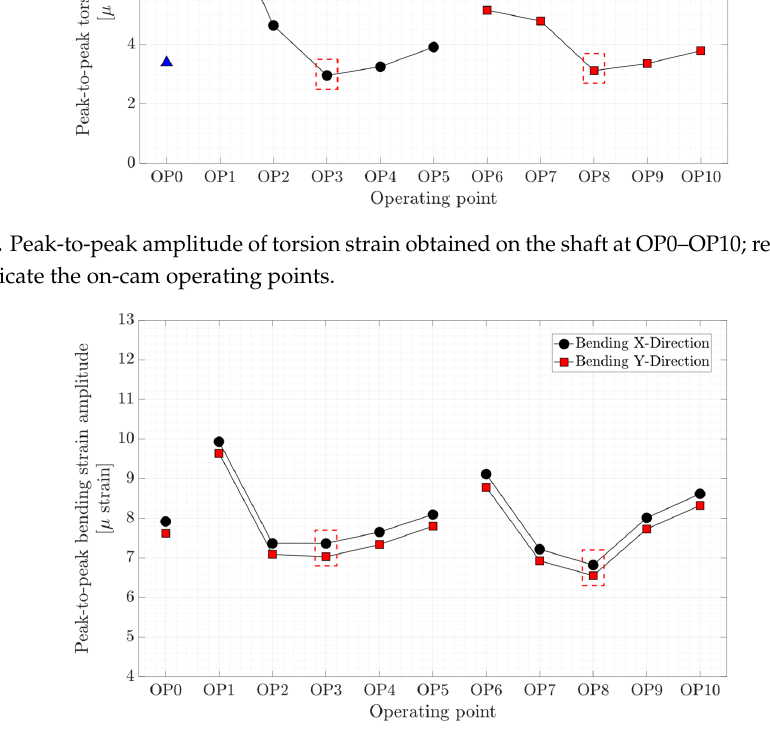
Figure 14. Peak-to-peak amplitude of bending strain obtained on the shaft at OP0–OP10; red dashed-line boxes indicate the on-cam operating points.